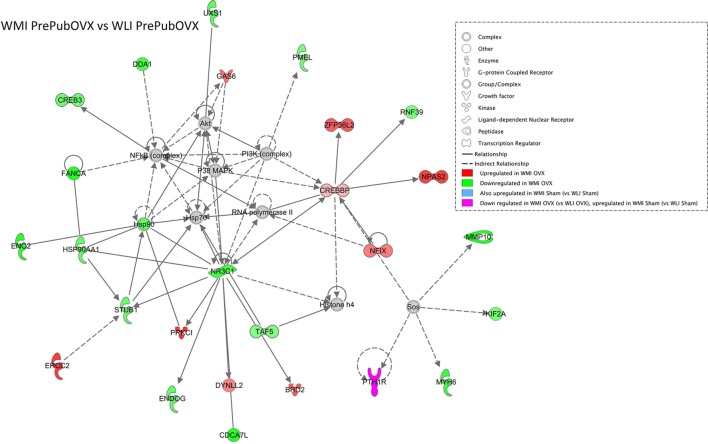
The most significant IPA Generated Network of Wistar Kyoto (WKY) more immobile (WMI) PrePubOVX vs. WKY less immobile (WLI) PrePubOVX differentially expressed genes (DEGs). DEGs with p < 0.01 were submitted to IPA with their corresponding fold changes using settings that allow for direct and indirect connections to other members of the network. Colored members are DEGs, while gray color indicates non-DEG connectors. The molecular/biological characteristics of the members are indicated in the legend.